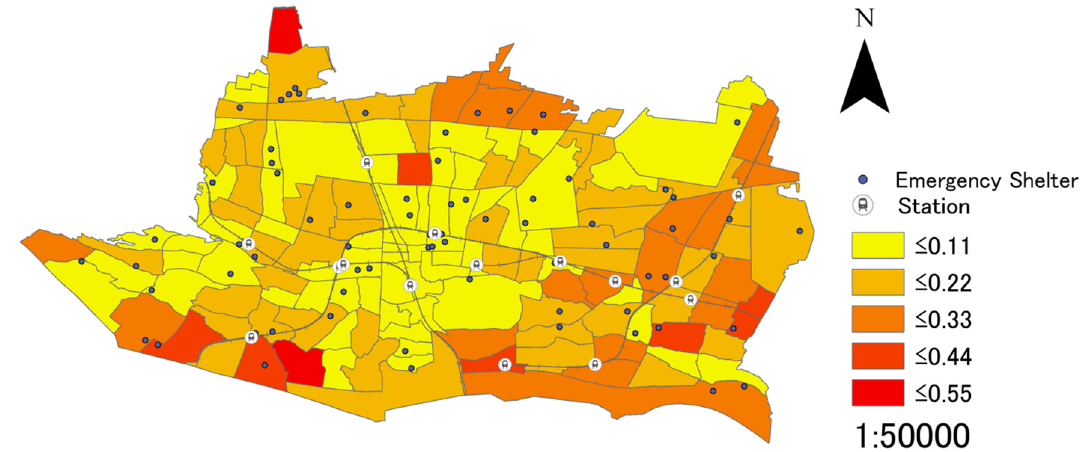
Figure 9. Result for Fuchu City with the ratio of elderly population as a weighted coefficient.